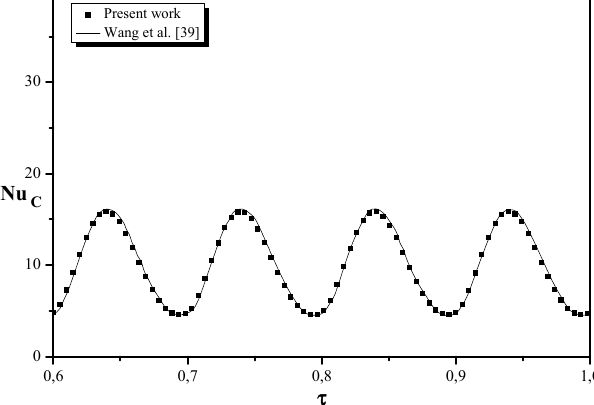
Figure 2. Time history of Nusselt numbers. Ra = 10 6 , Pr = 6.2, τ p = 0.1 and Amp = 0.8.